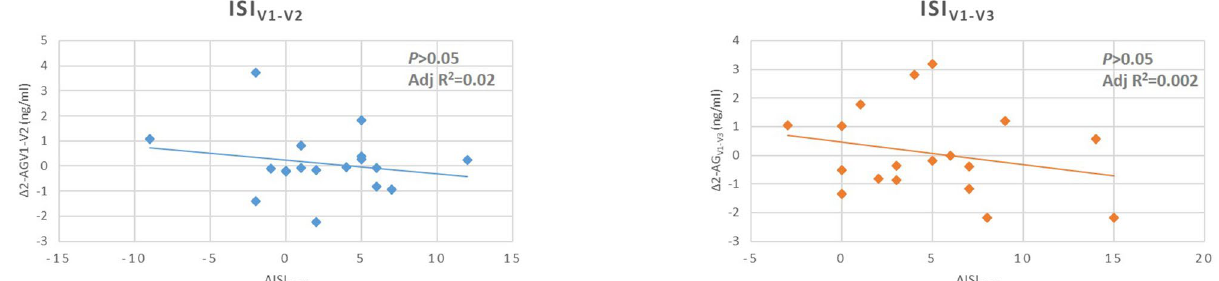
Figure 3. Regression analysis of the Insomnia Severity Index (ISI) score and serum 2-AG levels in different visits. Differences of serum 2-AG between visits are presented on the axis Y and differneces of phenotypic scores between visits are presented on the axis X. Associations were calculated with linear regression with enter method. BDI Beck Depression Inventory, MADRS Montgomery-Asberg Depression Scale, BAI Beck Anxiety Inventory, SHAPS Snaith–Hamilton Pleasure Scale, 2-AG 2-arachidonoylglycerol, AEA